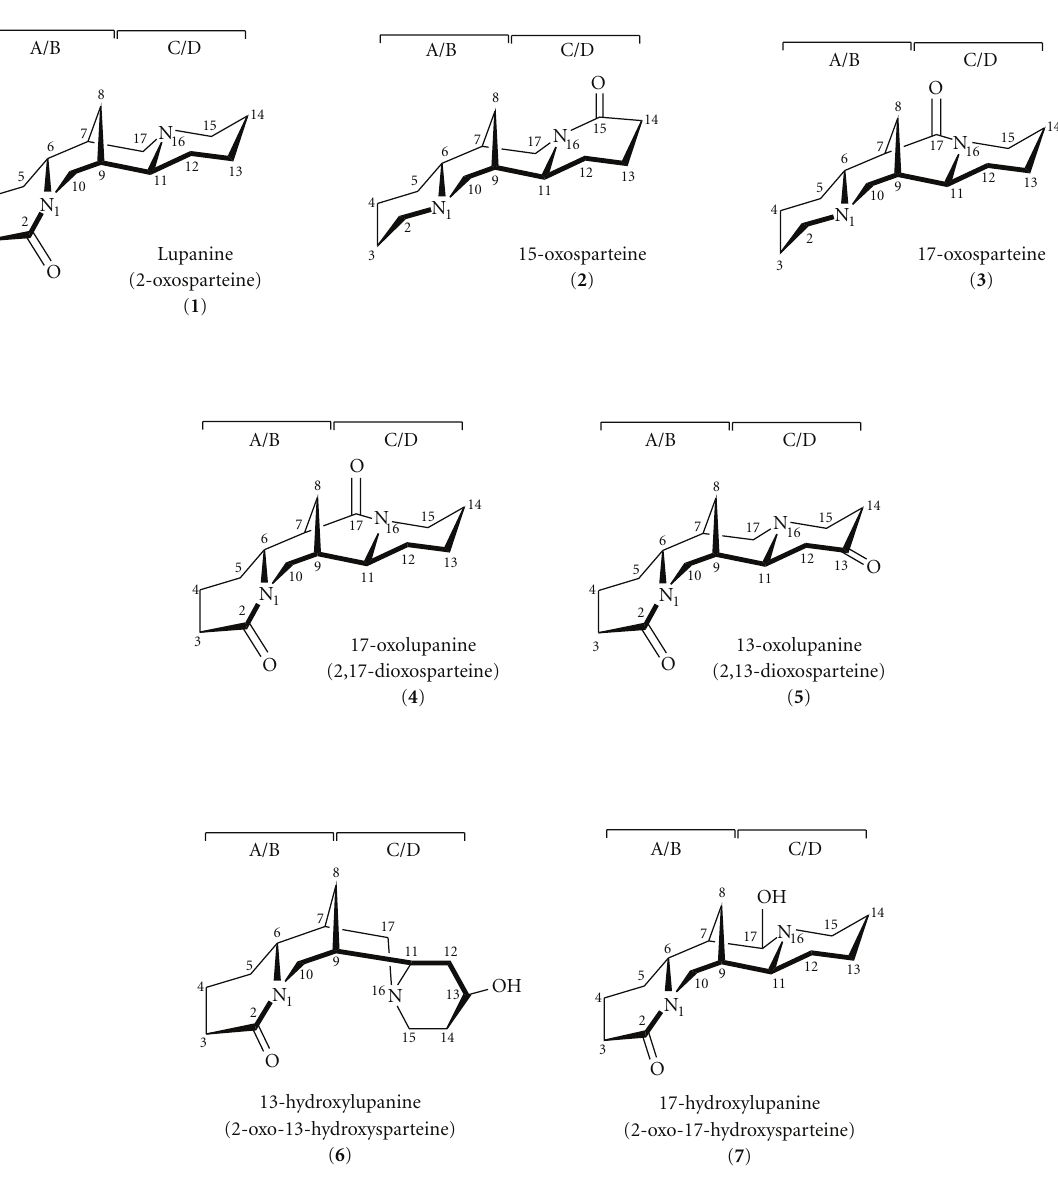
Figure 1: Structures of sparteine lactams ( 1 – 3 ), oxo-substituted derivatives of lupanine ( 4 , 5 ) and hydroxy-substituted derivatives of lupa- nine ( 6 , 7